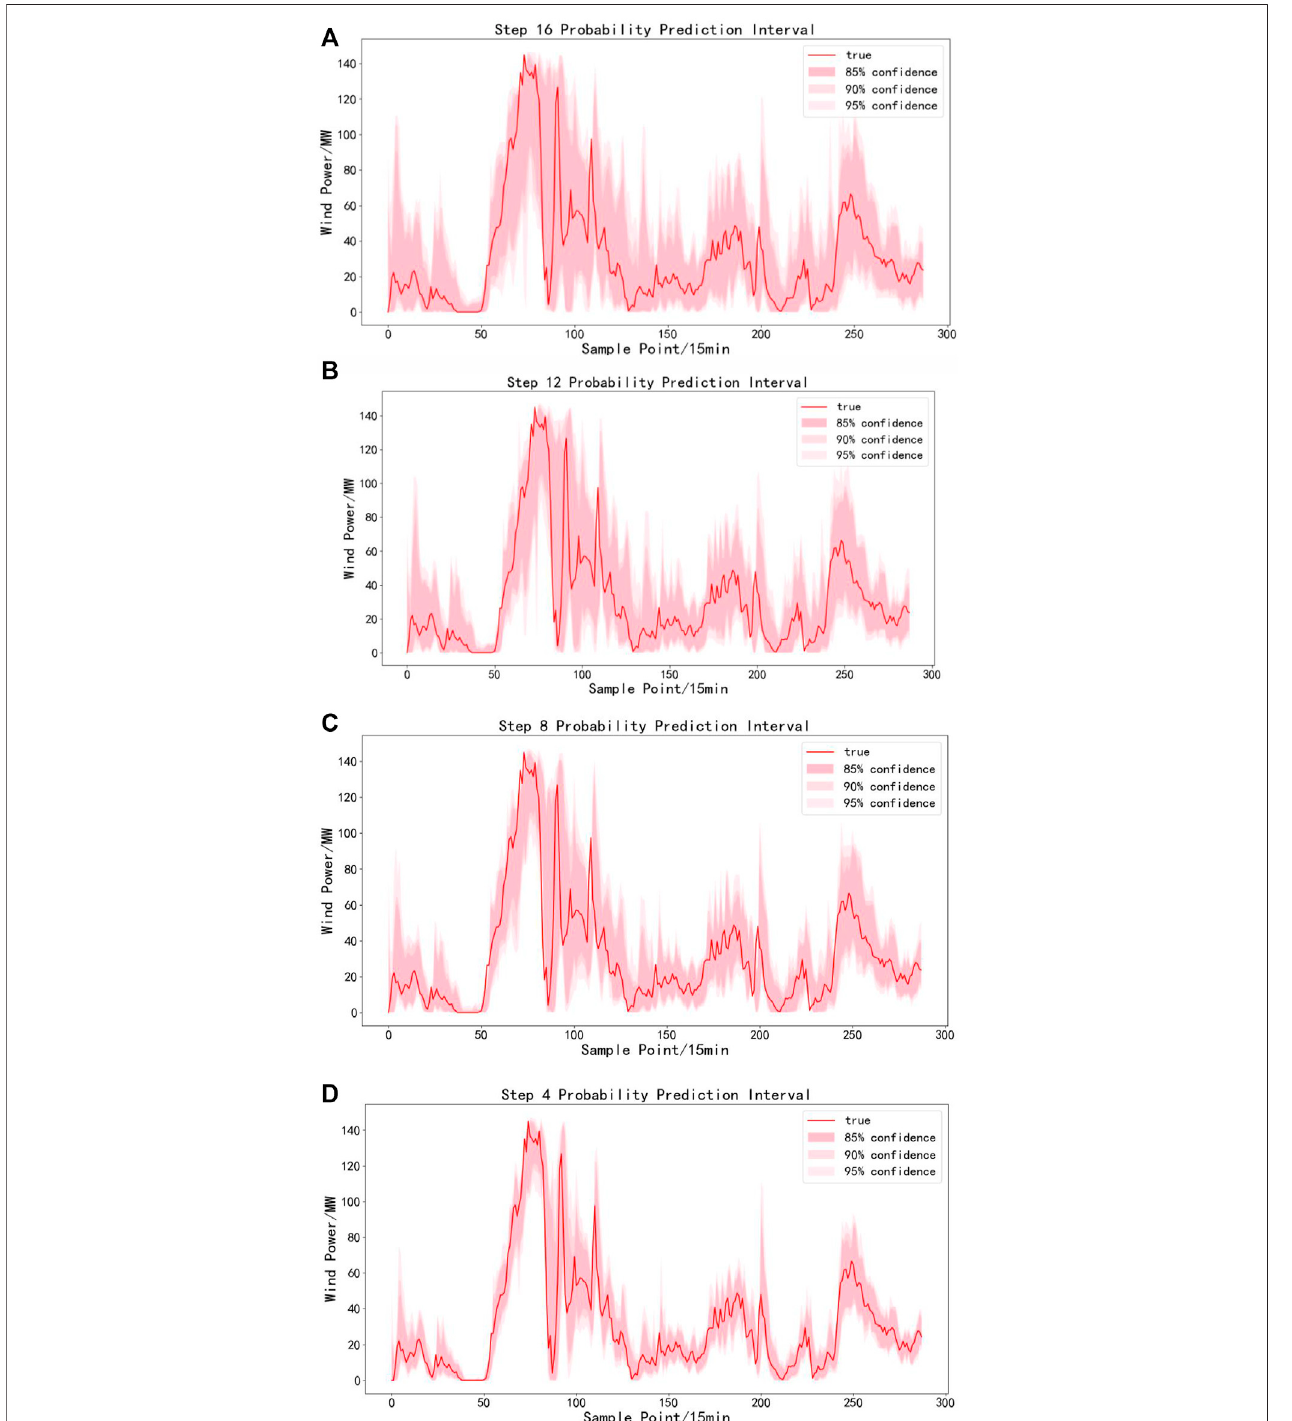
FIGURE6| Prediction interval ofproposed model in differenttimescales. Thelabels (A – D) istheintervalprediction effect diagram ofthemethodproposed in 16 th , 12 th , 8 th , 4 th .